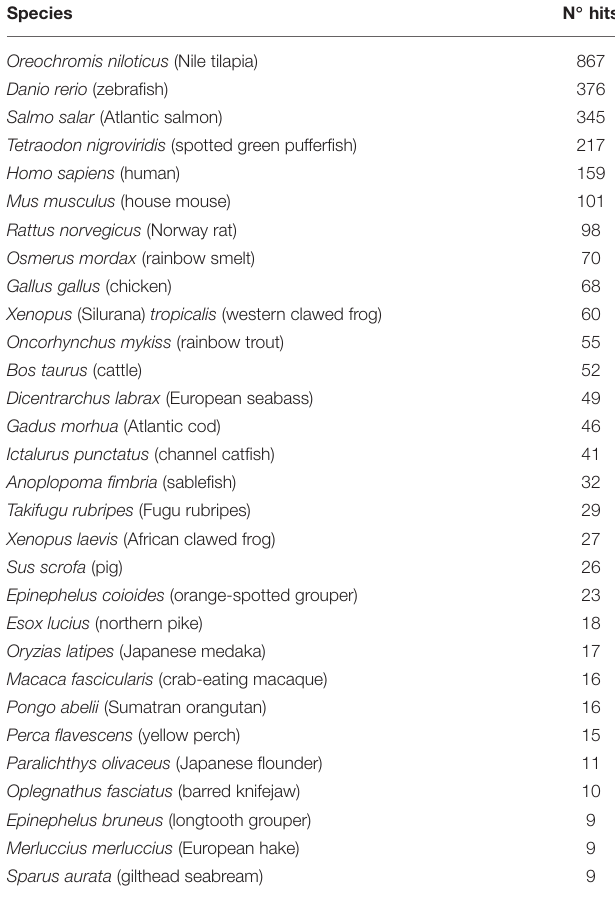
TABLE 3 | Top-hit species distribution of BLAST